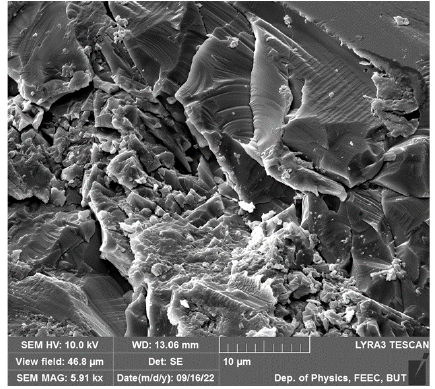
Figure 9. BFO sample surface.